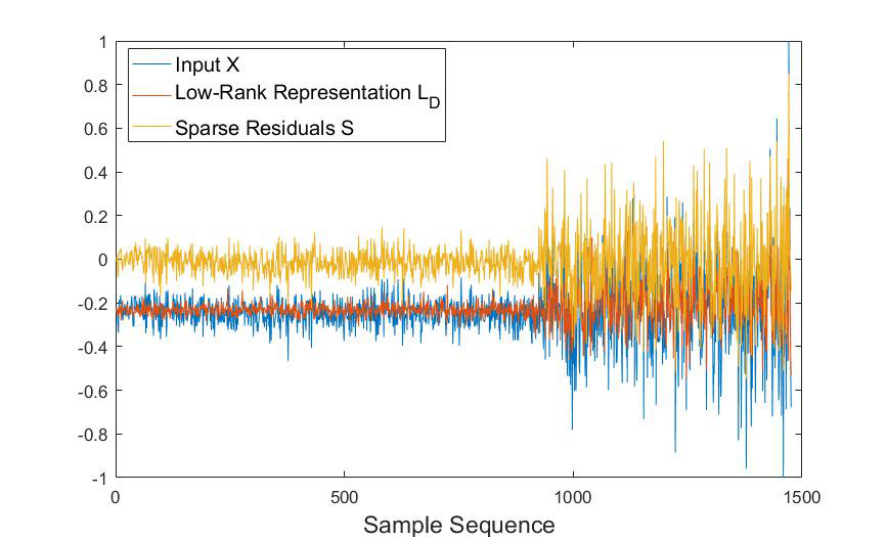
Figure 20. Decomposition results of the first feature extracted by RDA from Source 1 of Experiment 2.